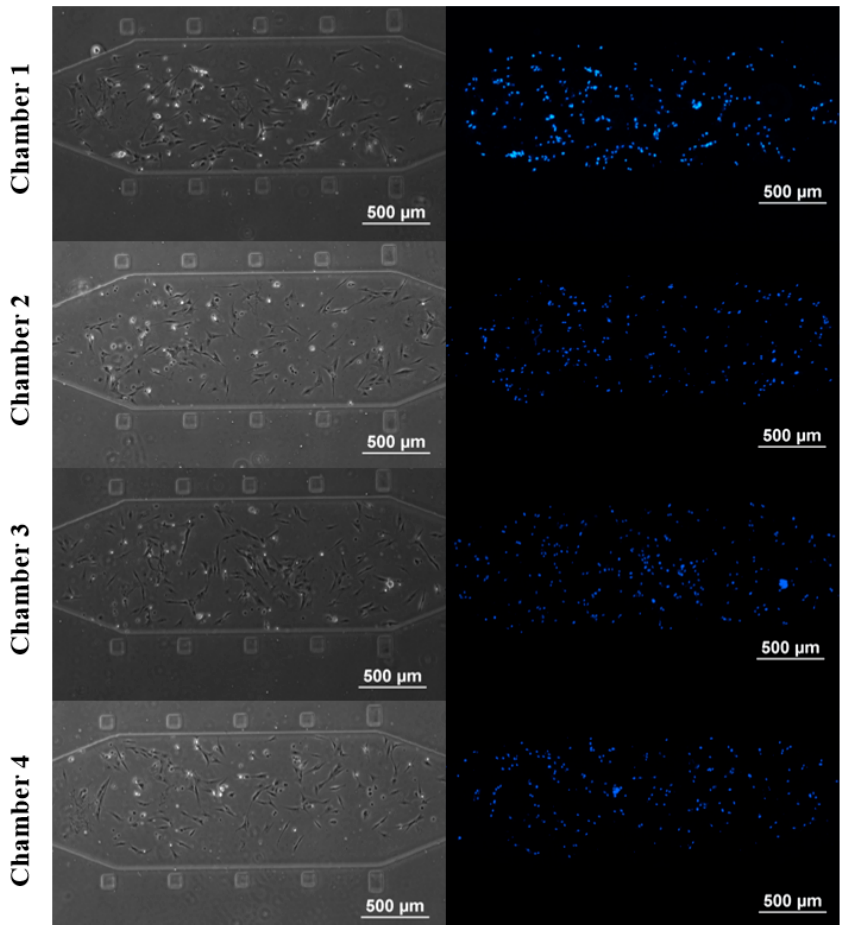
Figure 4. Microscopy (left) and DAPI-stained (right) images of rBMSCs culturing conditions in the microfluidic chambers 1–4.